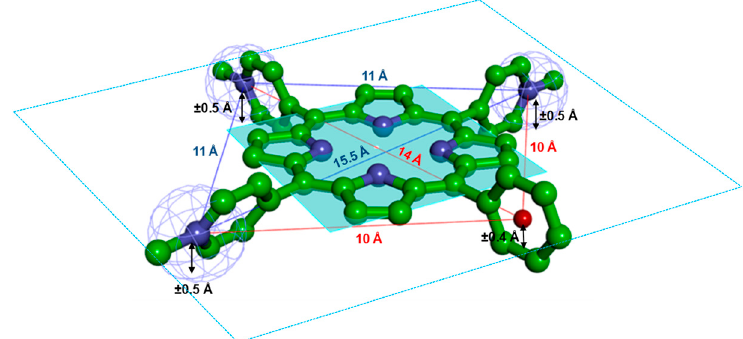
Figure 8. Tris ‐ T4 pharmacophore and related inter ‐ atomic distances and plane heights: (i) the positive ionizable pyridine nitrogen atoms are evidenced as mesh spheres; (ii) the centroid of the phenyl ring is displayed as a red ball and iii) the plane of the porphyrin ring is displayed and coloured in cyan. The global minimum conformer of Tris ‐ T4 is displayed in ball&stick and coloured by atom type (C: green; N: blue).